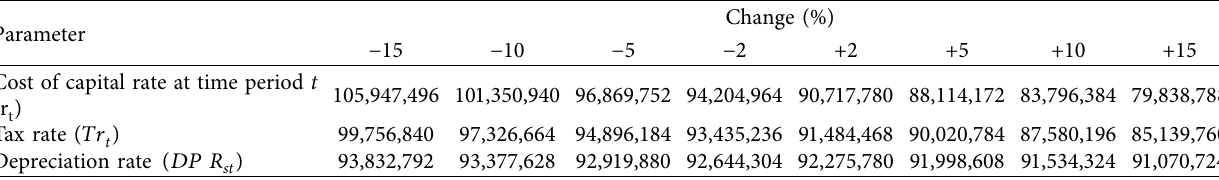
Table 8: Sensitivity analysis of value created according to changes in financial parameters.